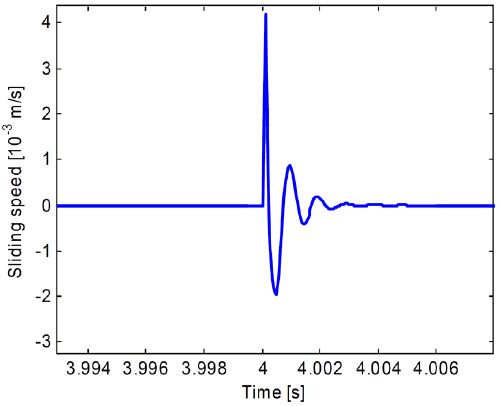
Figure 20. Sliding speed predicted using LuGre model.